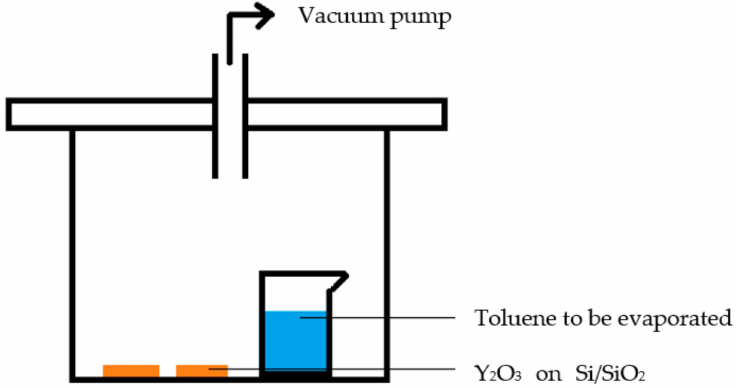
Figure 12. Enclosure where Y 2 O 3 films are exposed to toluene vapors, after being vacuumed. Table 3. WCA evolution of Y 2 O 3 ALD film before, immediately after annealing and over time. Experimental Conditions Before Annealing Right After Annealing In nitrogen, with hydrocarbon exposure In air, without hydrocarbon